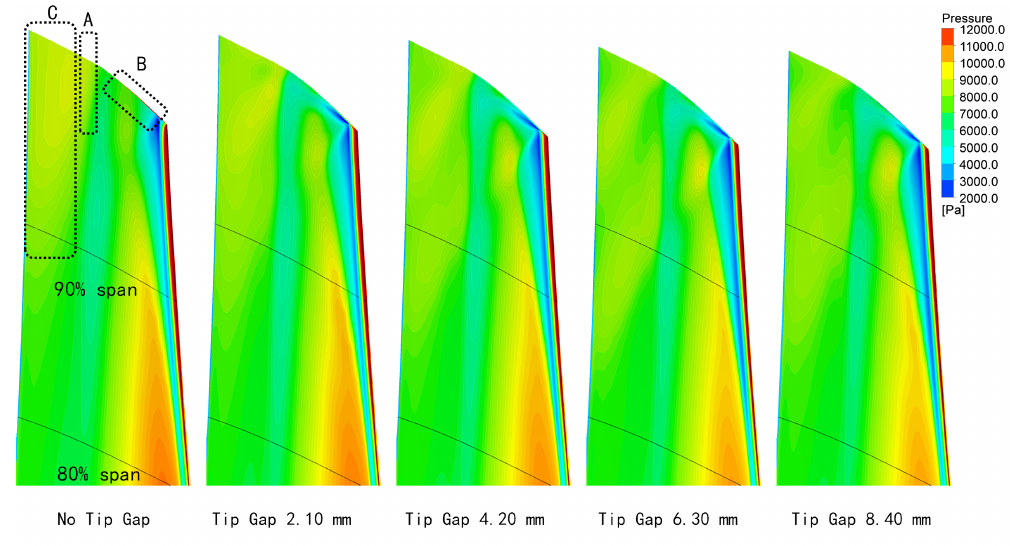
Figure 6. Blade loading in the steady state on the suction side of the rotor near the tip.